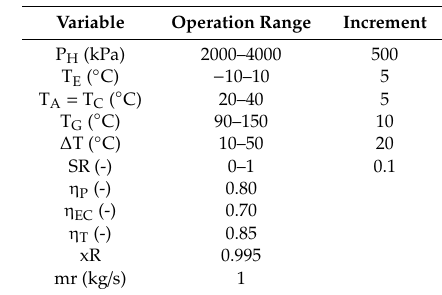
Table 4. Input data.